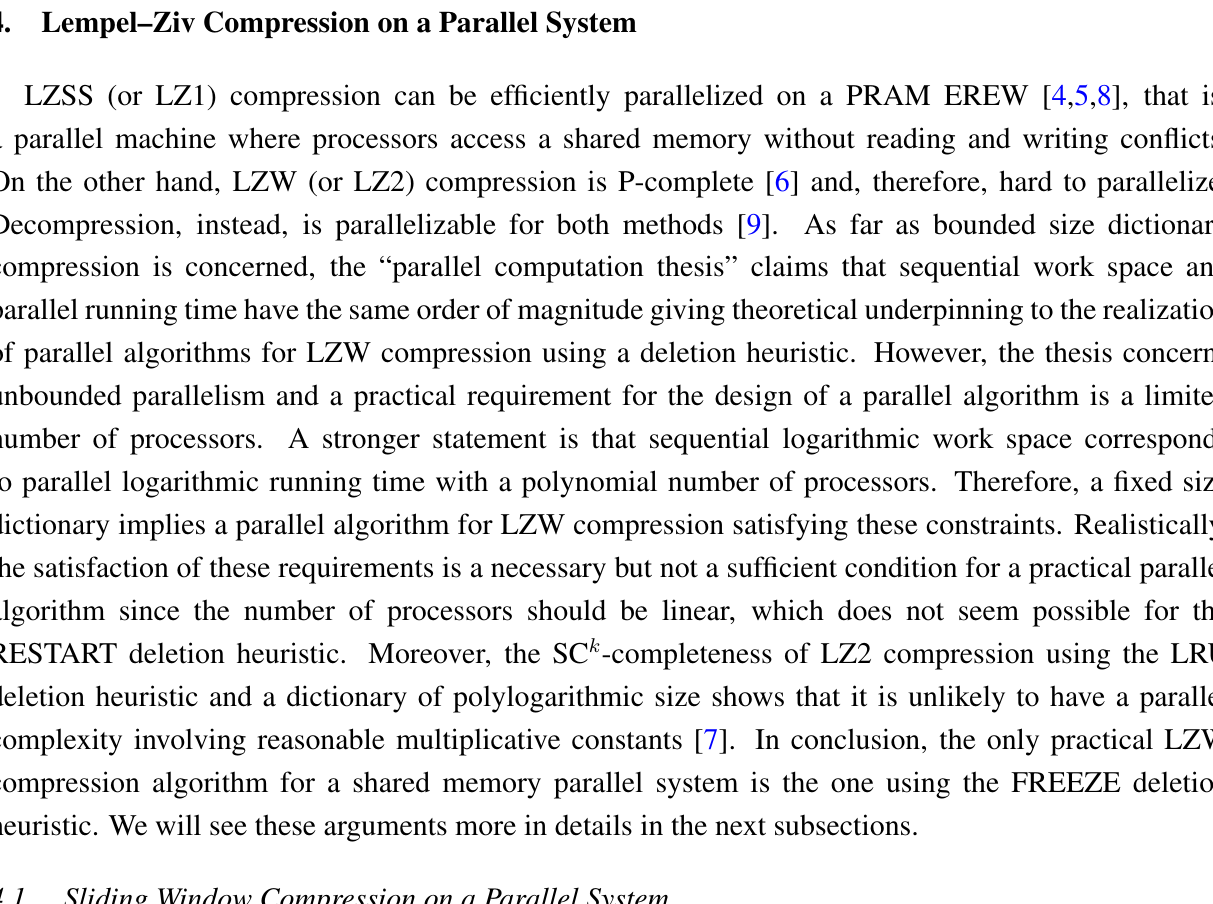
Figure 1. The semi-greedy factorization